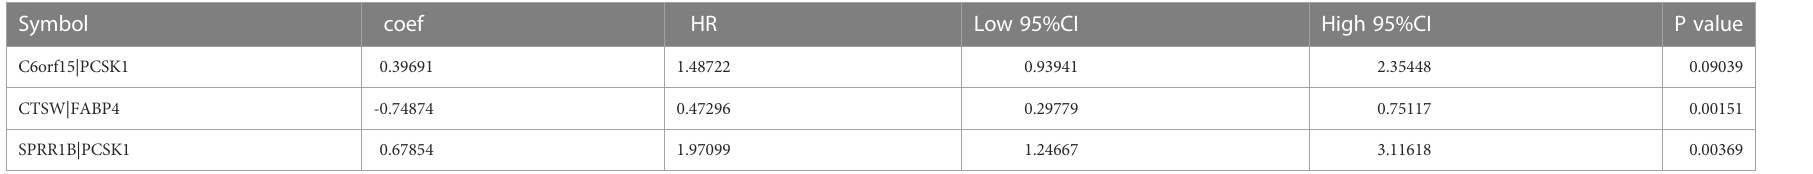
TABLE 2 Information of the three-mRNA